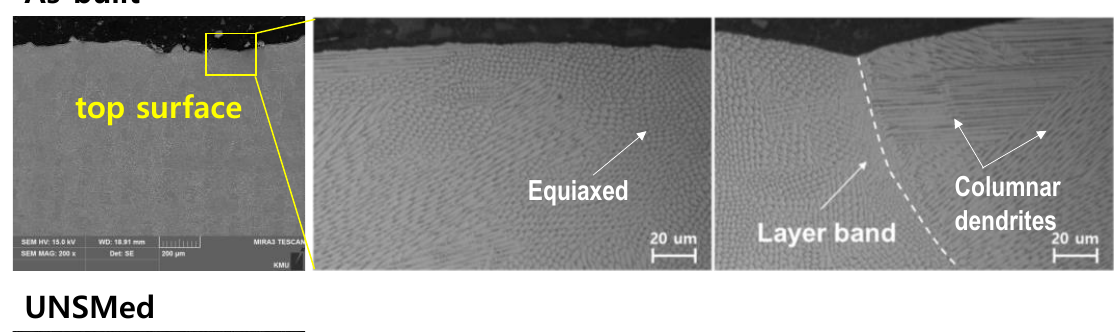
Figure 5. X-ray diffractograms of as-built and UNSMed specimens.